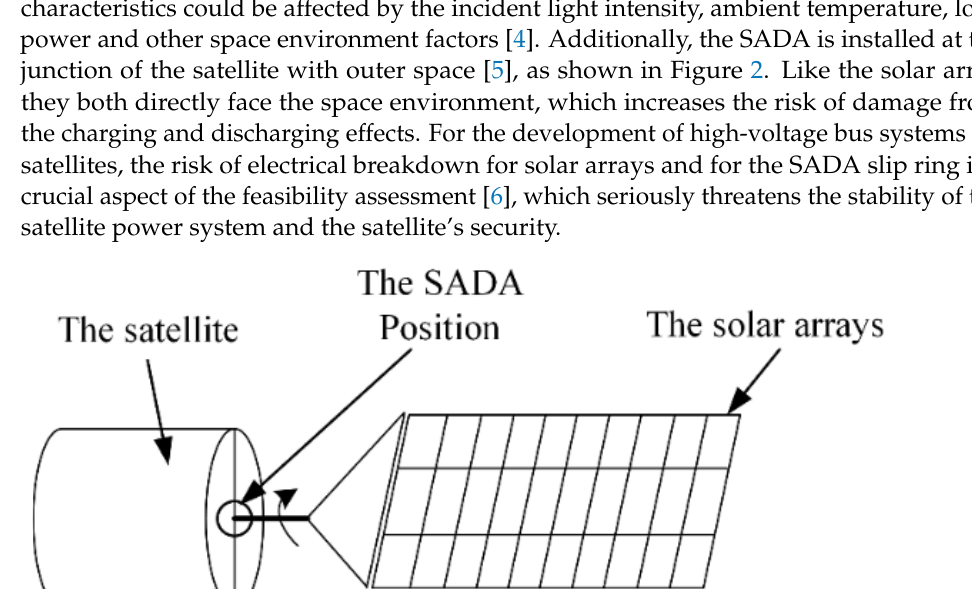
Figure 1. Schematic diagram of PCU.